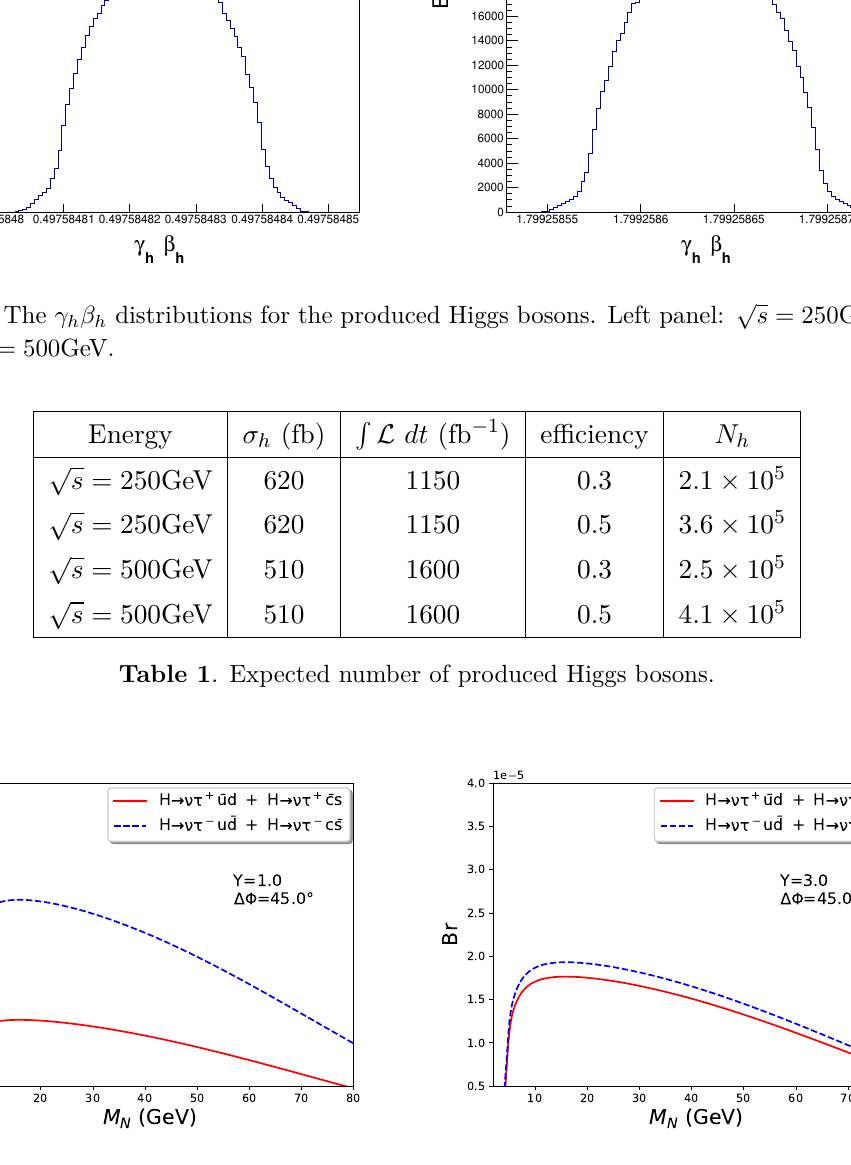
Figure 6 . Higgs boson Branching ratio as a function of HSN mass for different values of y ≡ ∆ M N / Γ N ( = 1 . 0 , 3 . 0 ) and ∆ φ = 45 o . Here we used | U τN | 2 = 10 − 5 and L = 1 m. The